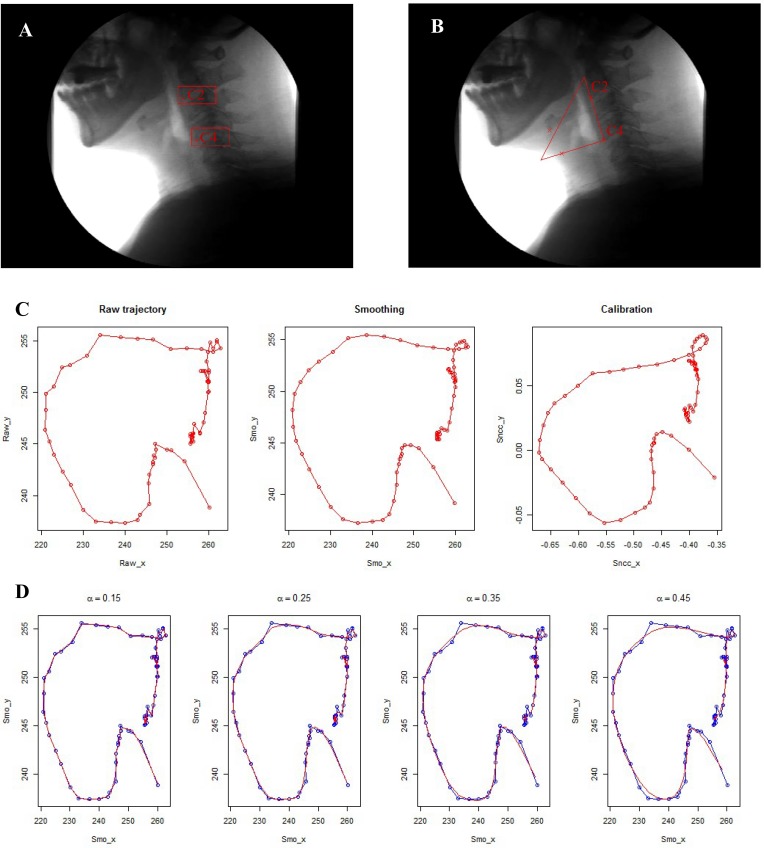
Example of smoothing and calibration.A. Manually specified two points, C2 and C4, indicated as two red crosses, in the anterior-interior border of the second and the fourth cervical vertebra at the beginning of tracking. B. The patient-centric coordinate system with the origin C4, where the y axis is defined as the line crossing C4 and C2 upward and the x axis is defined as the line vertical to the y axis leftward. C. The rugged trajectory in the left panel is raw data based on the image-centric coordinate system (in pixels) while the smoothing one in the middle and the calibrated one in the right panel which is based on a patient-centric coordinate system (in CU). D. Semi-automatic smoothing by adjusting the spline parameter, which ranges from 0.15 to 0.45. Blue curves represent the raw trajectory while the red ones are smoothing curves.